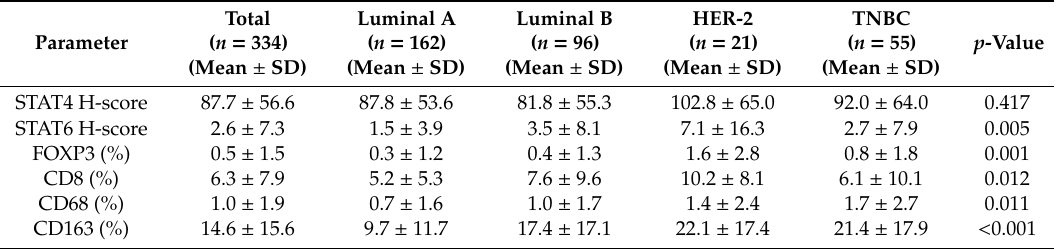
Table 2. Expression of immune cell subtype-related proteins according to the breast cancer molecular subtype (H-score or